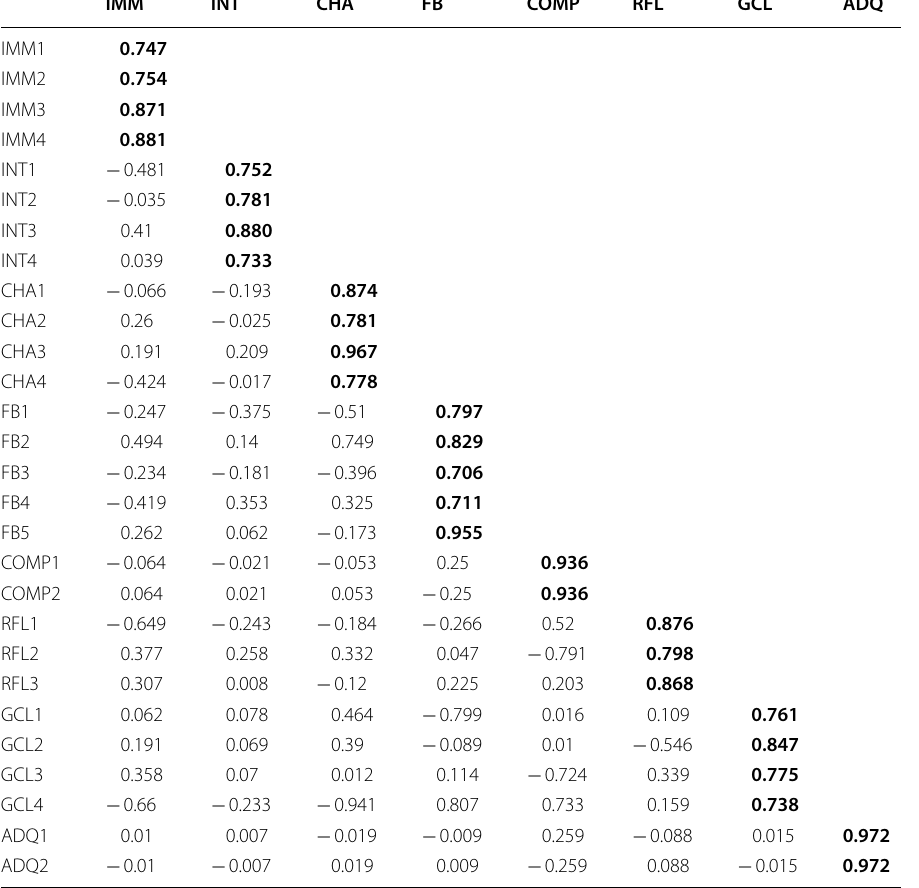
Table 2 Item combined loadings and cross loadings